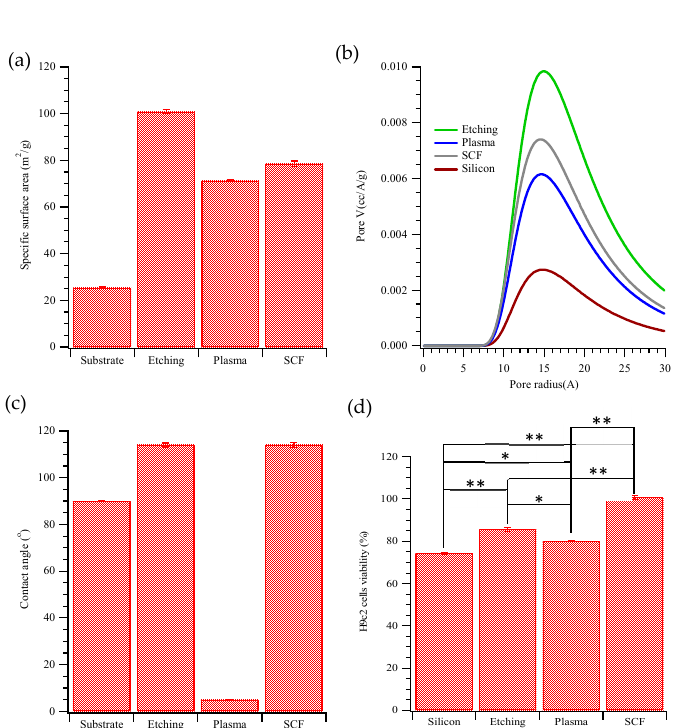
Figure 3. ( a ) The specific surface areas measured by nitrogen adsorption, ( b ) pore size distribution fitted by the Barrett-Joyner-Halenda (BJH) model, ( c ) the contact angles, and ( d ) viability (using the MTT test) of H9c2 cells grown on various substrates: tissue culture polystyrene (TCPS), silicon substrate, after etching, plasma treated, or scCO 2 treated (*p<0.05, **p<0.0005).